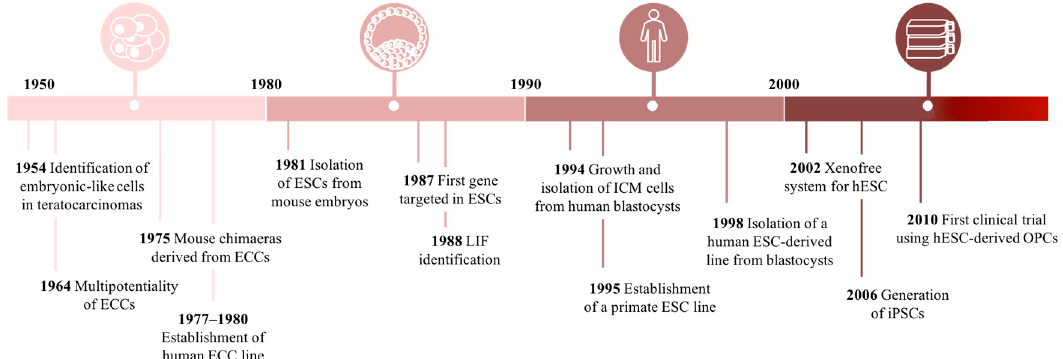
Figure 3. Timeline of embryonic stem cell (ESC)-based research. ICM: inner cell mass; OPC: oligodendrocyte progenitor cells; iPSCs: induced pluripotent stem cells; hESCs: human embryonic stem cells; ECCs: embryonal carcinoma cells.